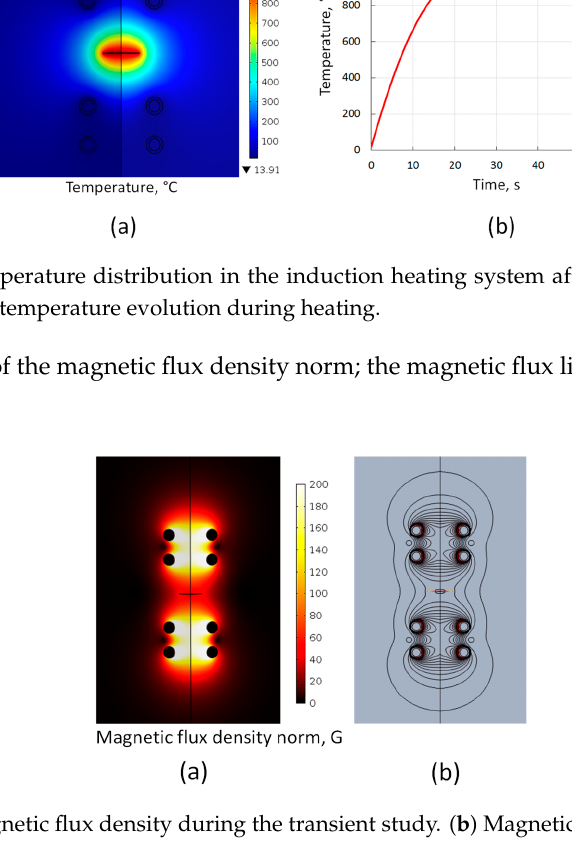
Figure 13. Current density contours along the copper foil.